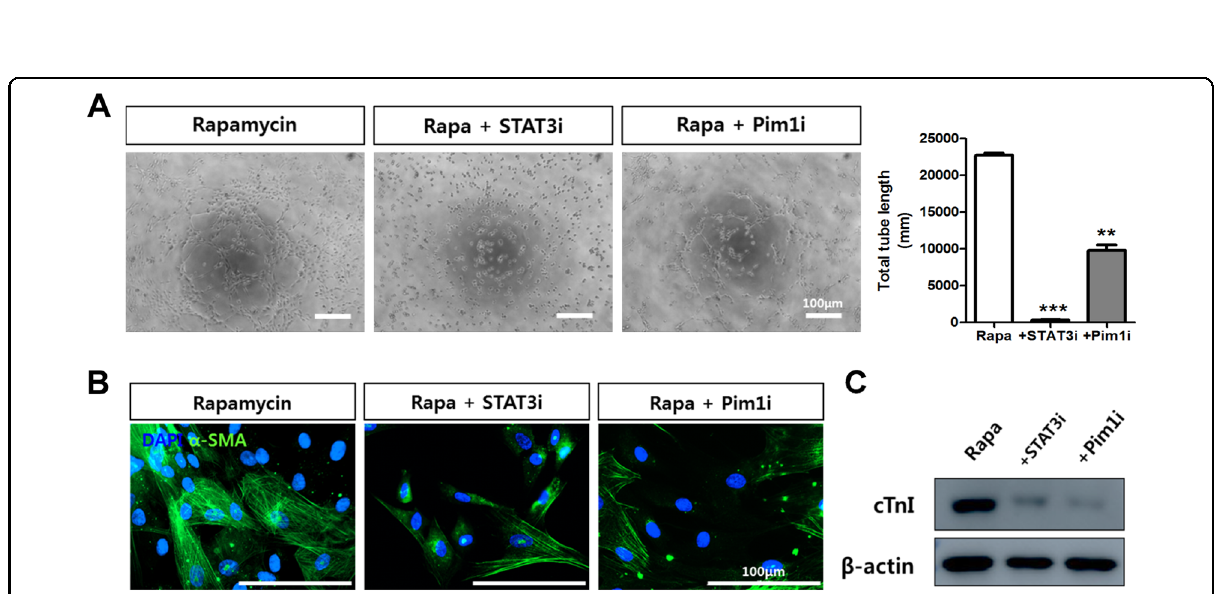
Fig. 7 The STAT3-PIM1 axis affects the differentiation ability of rapamycin-treated hCPCs. a A STAT3 inhibitor (10 μ M) and a Pim1 inhibitor (20 μ M) were added to rapamycin-treated hCPCs, and Matrigel tube formation assays were examined. Data represent the mean ± SEM of three independent experiments (** p ≤ 0.01, *** p ≤ 0.001, vs. prolonged rapamycin-treated hCPCs). b Smooth muscle differentiation ability as analyzed by α -SMA staining after induced differentiation (scale bar = 100 μ m). c Myogenic potential was analyzed by cTnI immunoblot assay after 28 days of induced differentiation. Abbreviation: STAT3i STAT3 inhibitor, Pim1i Pim1